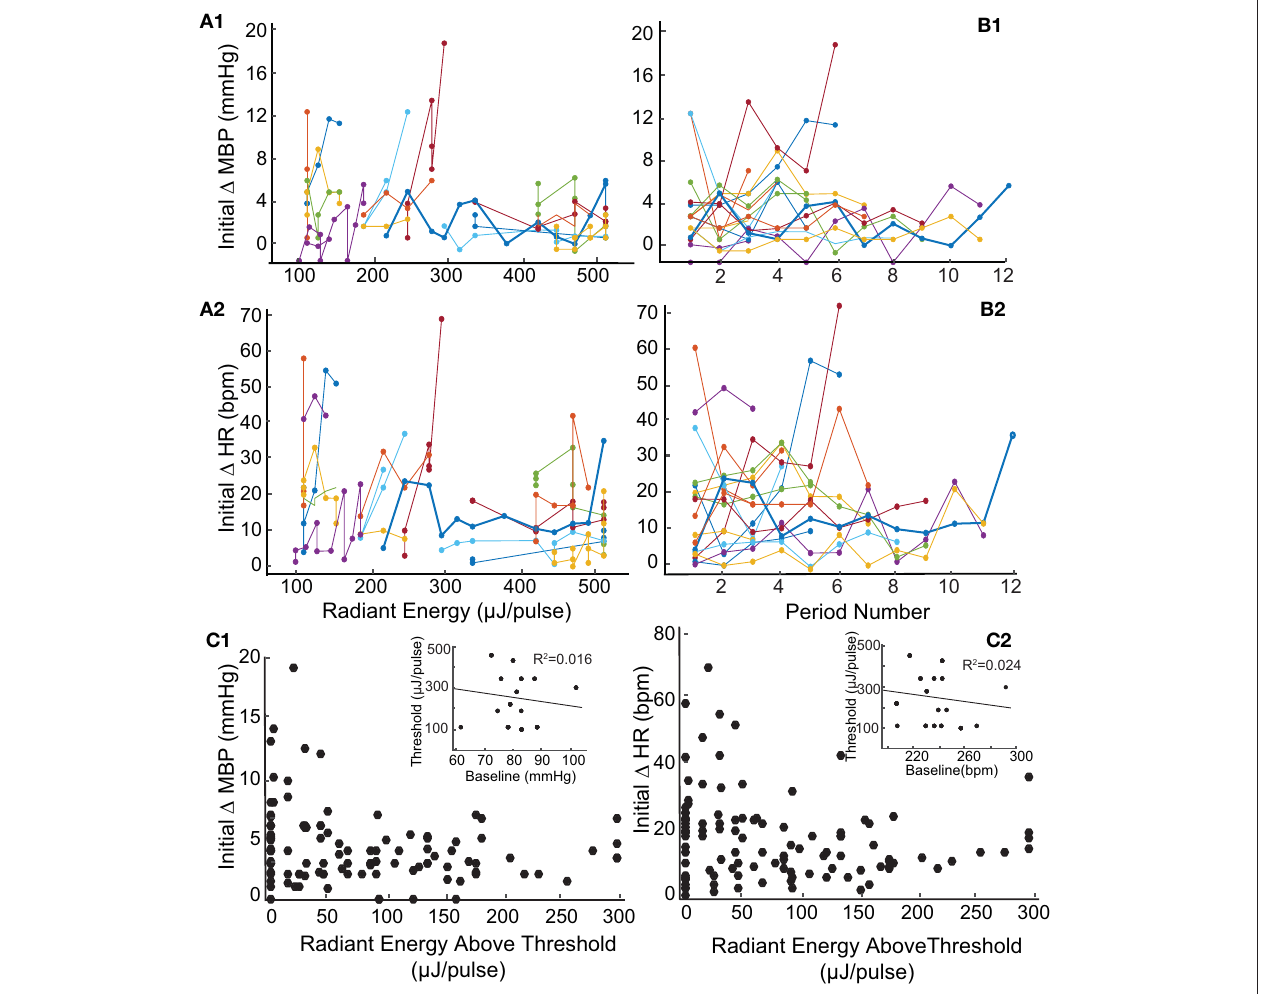
FIGURE 4 | Relationship between magnitude of change in blood pressure and heart rate and radiant energy or IR stimulation trials. (A) There is a no correlation between stimulation radiant energies ( µ J/pulse) and the initial changes in (A1) MBP (mmHg) ( r = − 0.331) and (A2) HR (bpm) ( r = − 0.269). The results shown are from 113 IR stimulation events across 17 rats. (B) Shows the relationship between consecutive IR stimulation periods and the magnitude of change in (B1) MBP (mmHg) ( r = − 0.0647) and (B2) HR (bpm) ( r = − 0.0725) in 17 rats. The responses over multiple IR stimuli for individual rats are represented using different colors. (C1,C2) The initial changes in both parameters with stimuli radiant energy normalized to that at thresholds are shown. The insets show a weak correlation of threshold radiant energy required to evoke a response to baseline MBP or